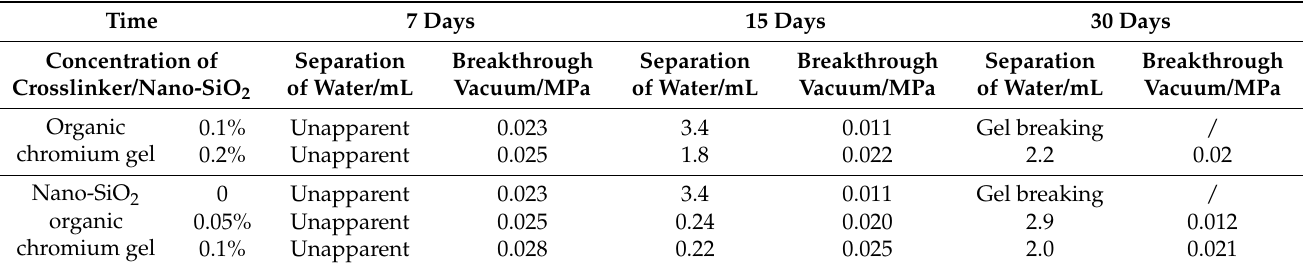
Table 5. Stability evaluation of the gel and nano-SiO 2 gel.